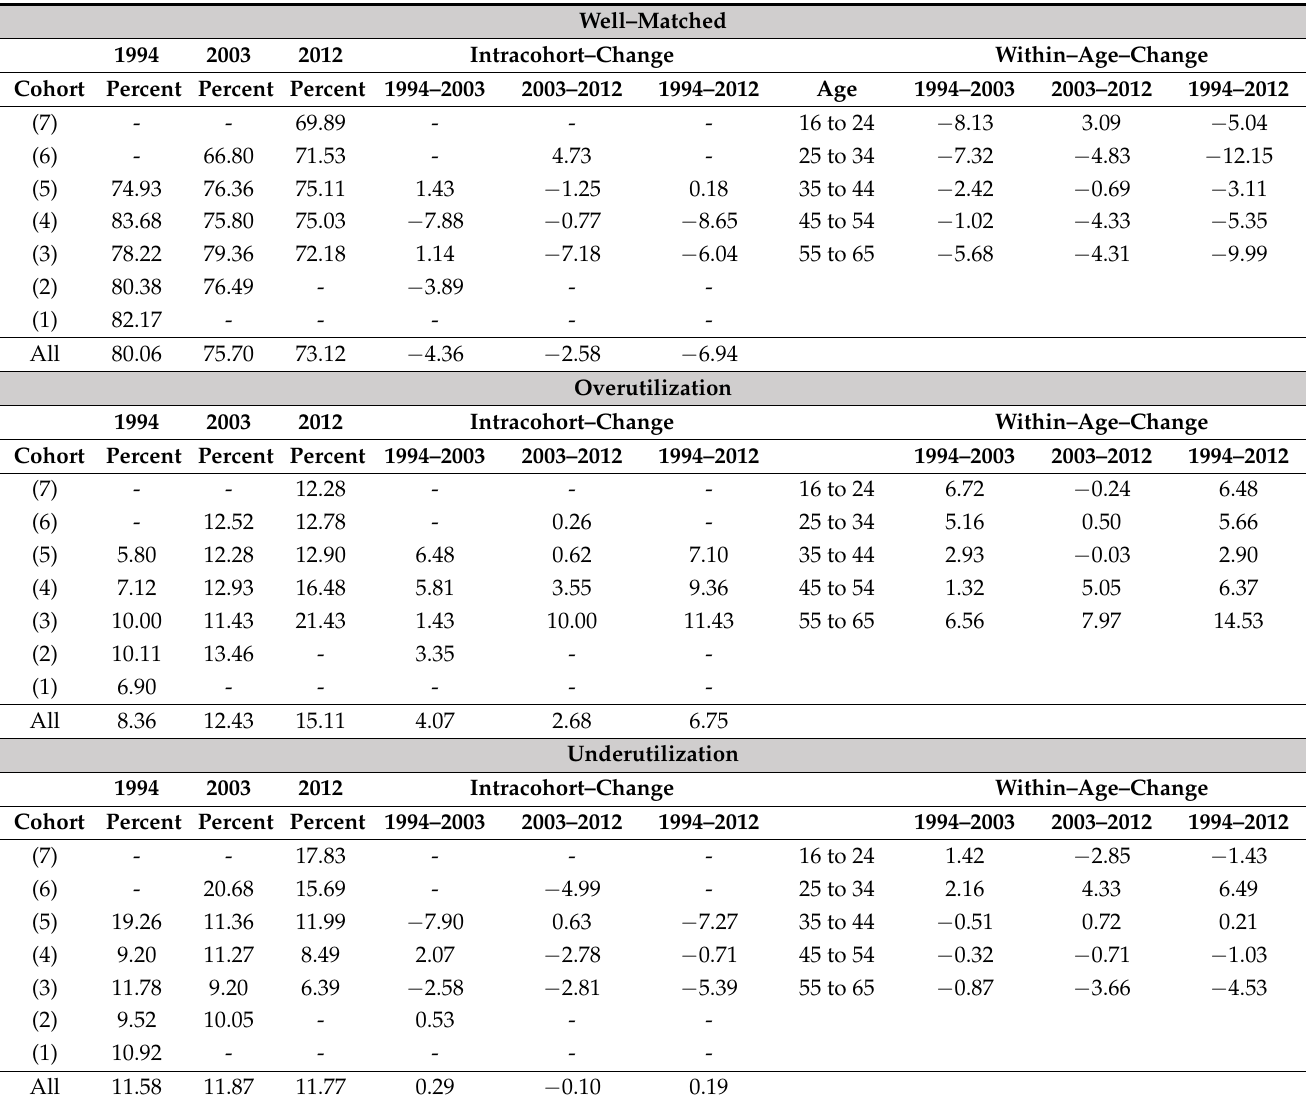
Table A1. The incidence and change of literacy skill mismatch.